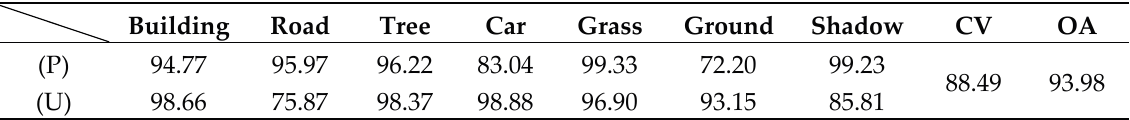
Figure 5. ( a ) The orthophoto; ( b ) DSM; ( c ) zoom-images of a parking area; ( d ) reference data; ( e ) classification map of the proposed method. Table 2. Classification results of Experiment 1 (percentage (%)) (per-class producer’s (P) and user’s (U) accuracy). CV,